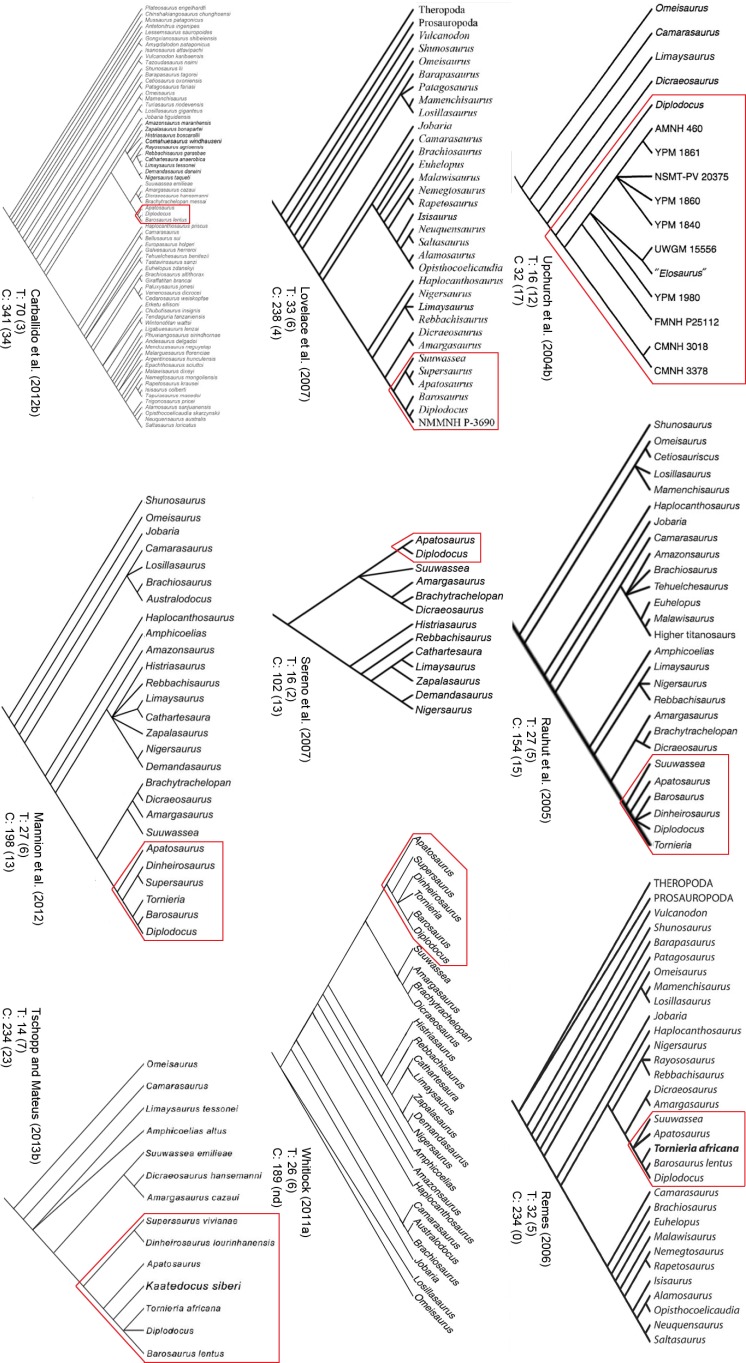
Strict consensus trees of previous phylogenetic analyses with special focus on diplodocoid intrarelationships, with the number of taxa (T) and characters (C) indicated.In brackets the number of diplodocid taxa and newly proposed characters. Taxon names were changed according to more recent publications, and diplodocid OTU highlighted with the red box.